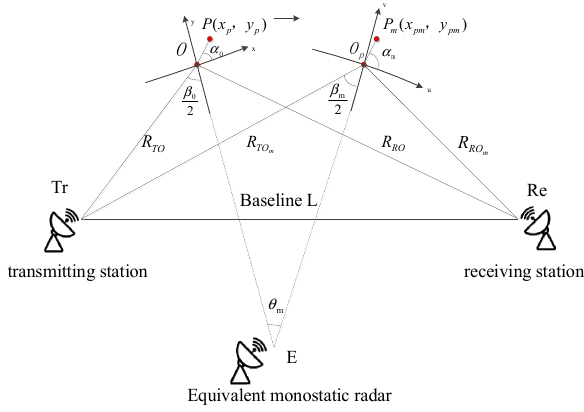
Figure 1. The Bi − ISAR imaging geometric model. Figure 1. The Bi–ISAR imaging geometric